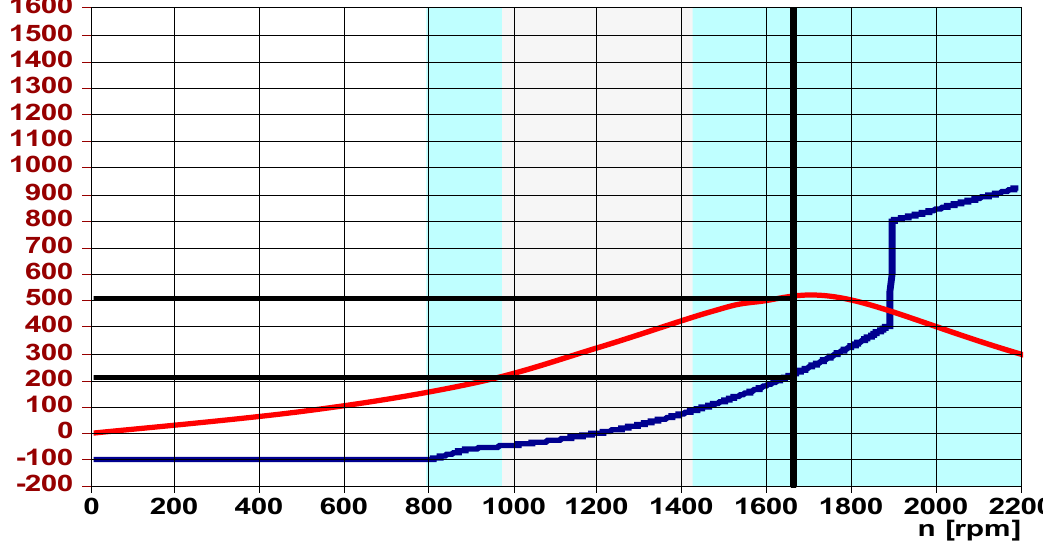
Figure 15. A wind turbine based on DFIG with a speed of 8.5 m/s.